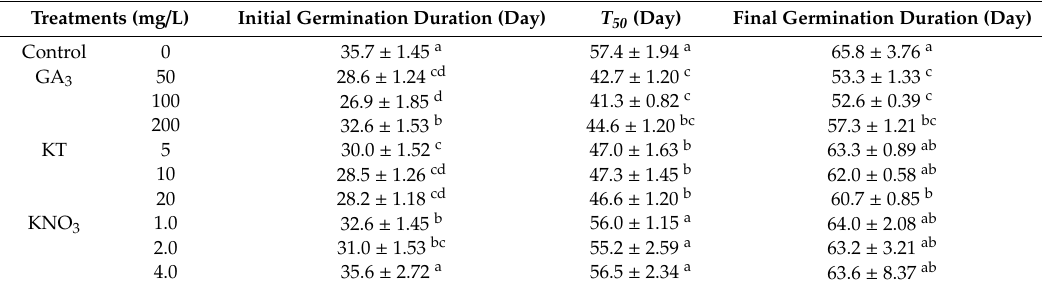
Table 2. The seed germination days of Tulipa thianschanica incubated with di ff erent plant growth regulator treatments at 4 ◦ C.